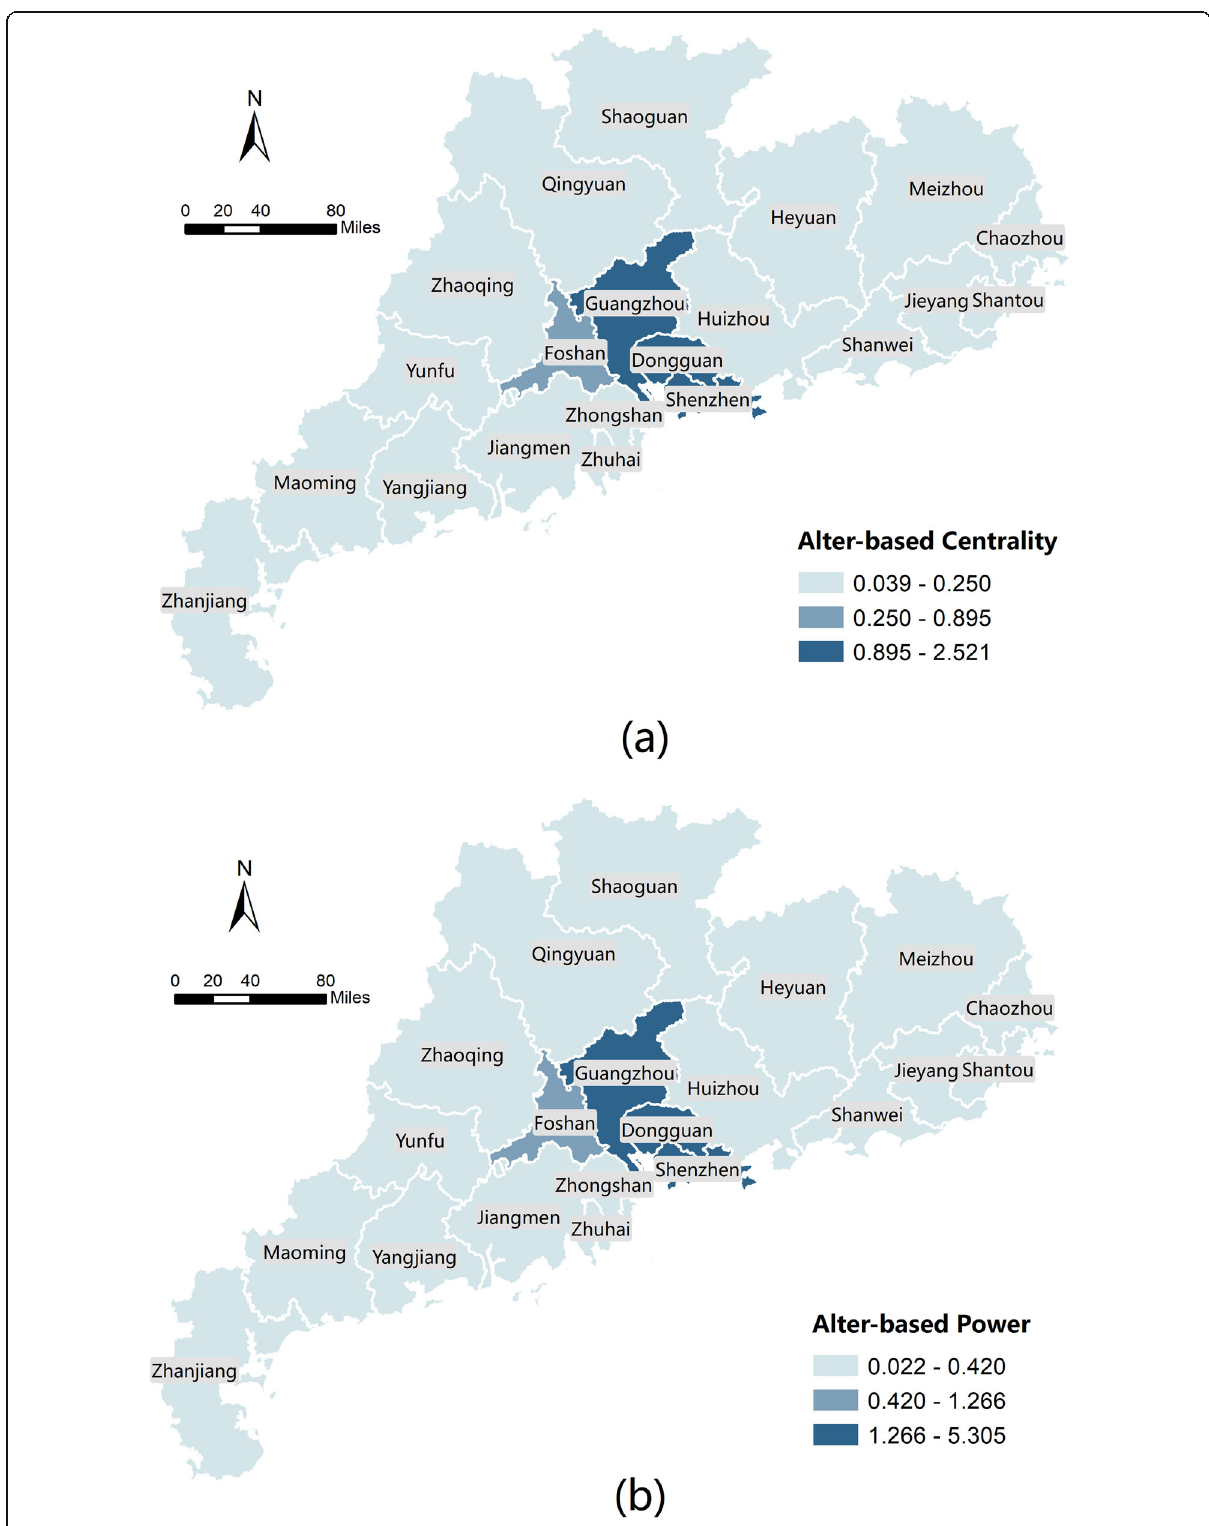
Fig. 5 Altered Centrality and power of Cities: (a) alter-based centrality of cities; (b) alter-based power of